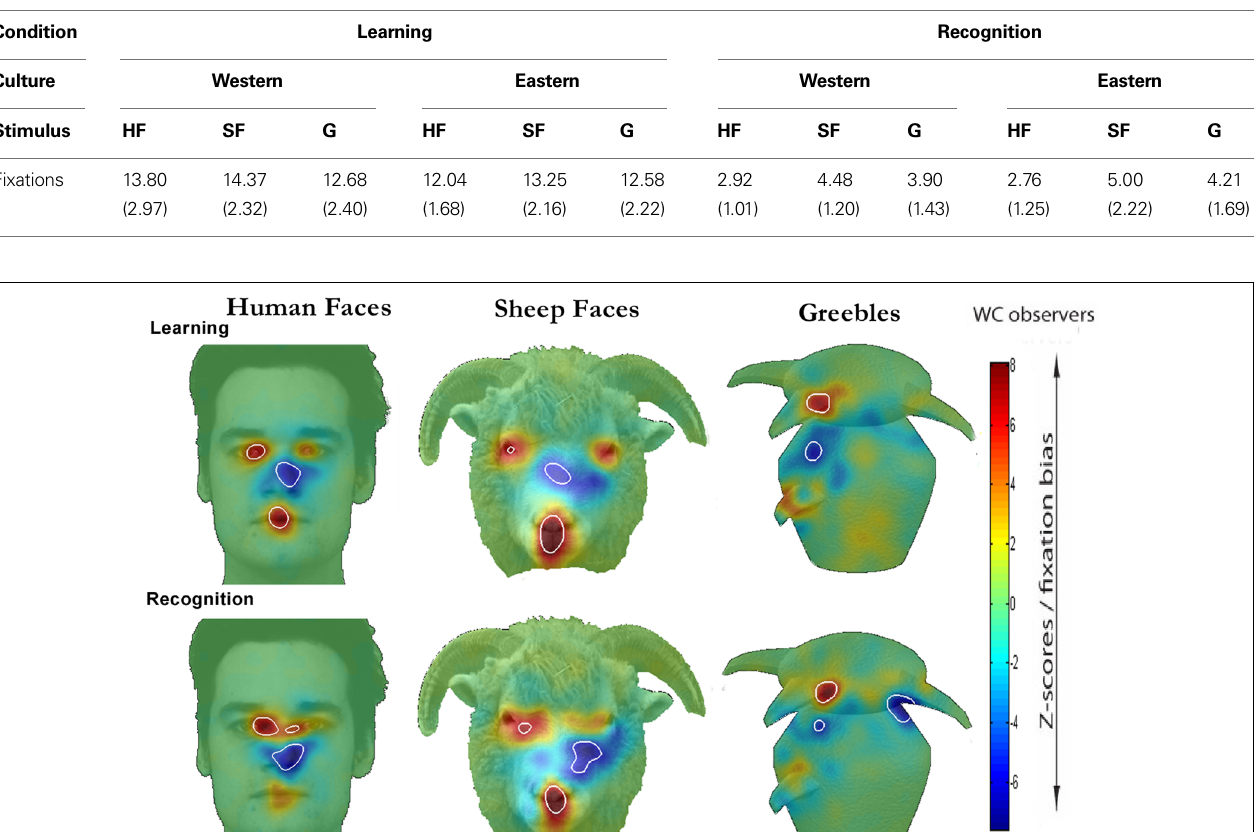
their fi xations around the eye and mouth regions, whereas EA participants fi xate more centrally. Most surprisingly, strategic dif- ferences between groups are even found for greebles . EAs centered more fi xations between the two prominent features (head and body limbs) whilst WCs landed their fi xations directly on the central head